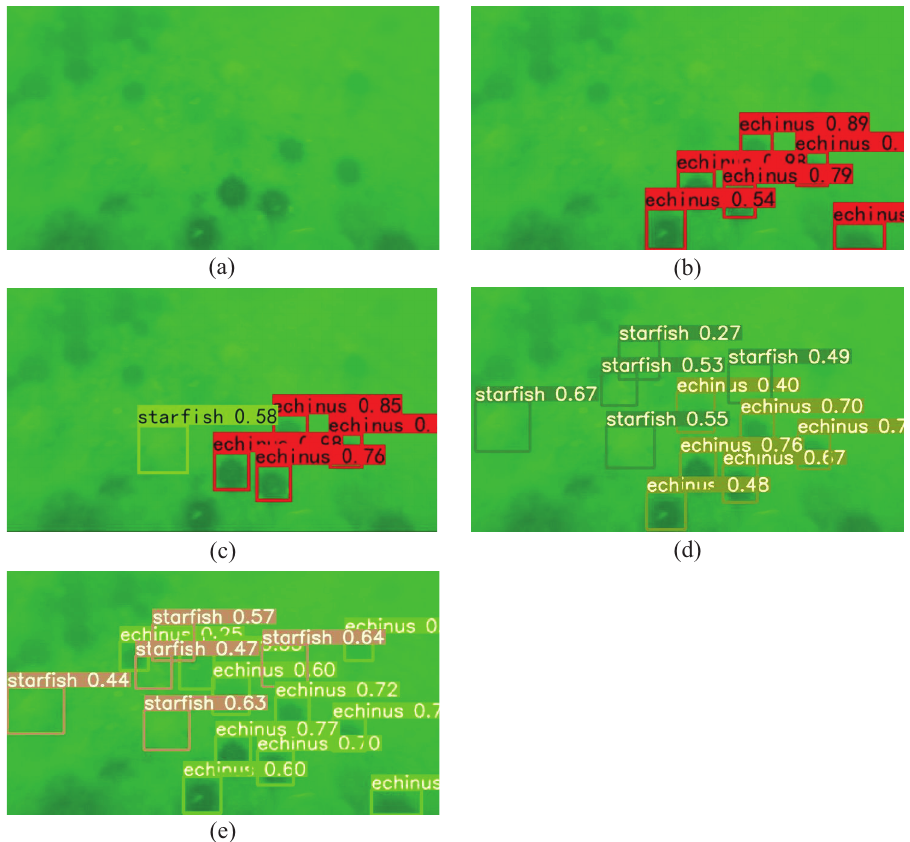
Figure 11. Detection results of different detection models. ( a ) Original underwater image, ( b ) de- tection result of the trained YOLOv3 model, ( c ) detection result of the trained YOLOv4 model, ( d ) detection result of the original YOLOv5s model, and ( e ) detection result of the YOLOv5s-UW model proposed in this